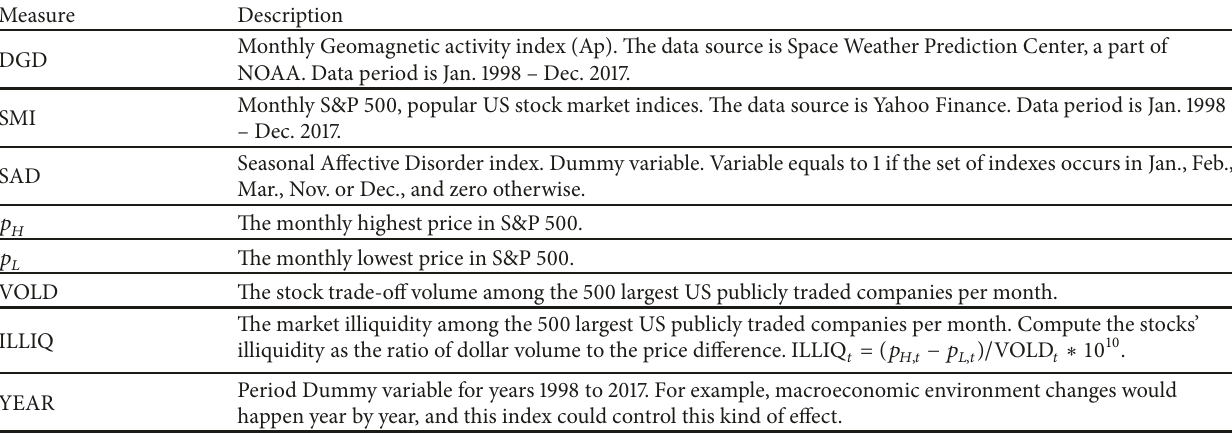
Table 1: Variable